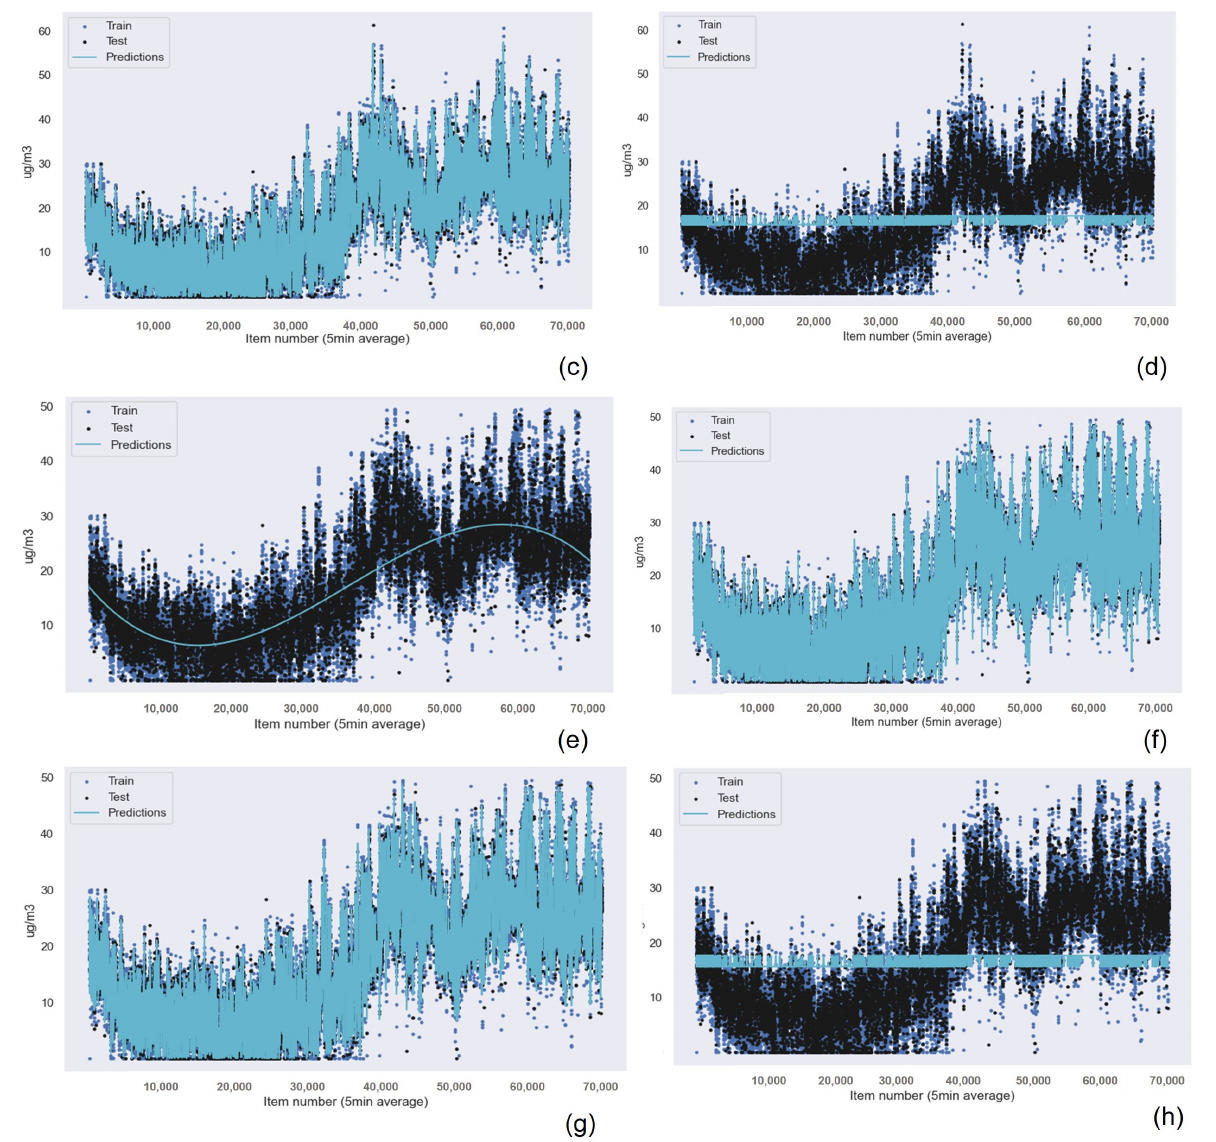
Figure A5. NO 2 results with outliers for ( a ) Linear Regression ( b ) Random Forest Regression ( c ) KNN and ( d ) Support Vector Machine, and without outliers for ( e ) Linear Regression ( f ) Random Forest Regression ( g ) KNN and ( h ) Support Vector